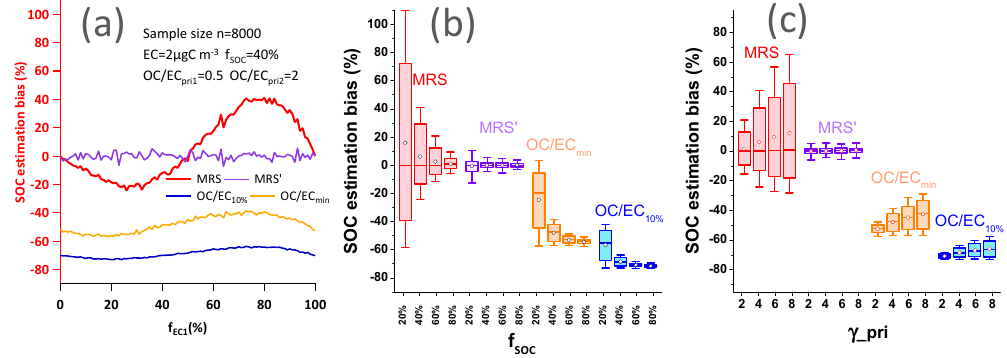
Figure 6. SOC bias in Scenario 3 (two independent primary emission sources of different (OC / EC) pri ) as estimated by four different EC tracer methods denoted in red, purple, yellow and blue. MRS (cid:48) differs from MRS in that EC 1 and EC 2 instead of total EC are used as inputs. (a) SOC bias as a function of f EC1 . Results shown here are calculated using f SOC = 40% and γ _pri = 4 as an example. (b) Range of SOC bias shown in boxplots for four f SOC conditions (20, 40, 60 and 80%). (c) Range of SOC bias shown in boxplots for four γ _pri conditions (2, 4, 6 and 8). The symbols in the boxplots are empty circles as average, the line inside the box as median, upper and lower boundaries of the box representing the 75th and the 25th percentile, and the whiskers above and below each box representing the 95th and 5th